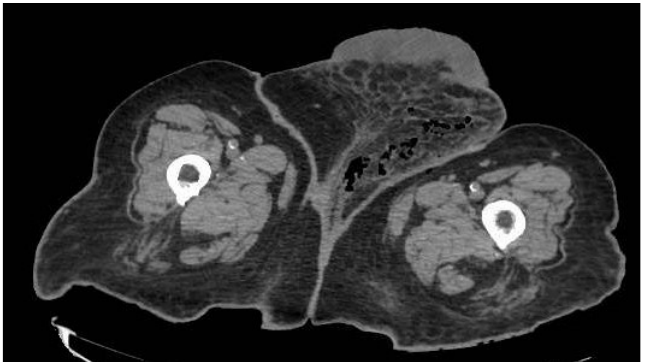
Figure 4. CT of the abdomen and pelvis showed a FG which involves a soft tissue emphysema extending from the left labia majora to left femoral region, associated to a thickening and trabeculation of fatty tissues around them.